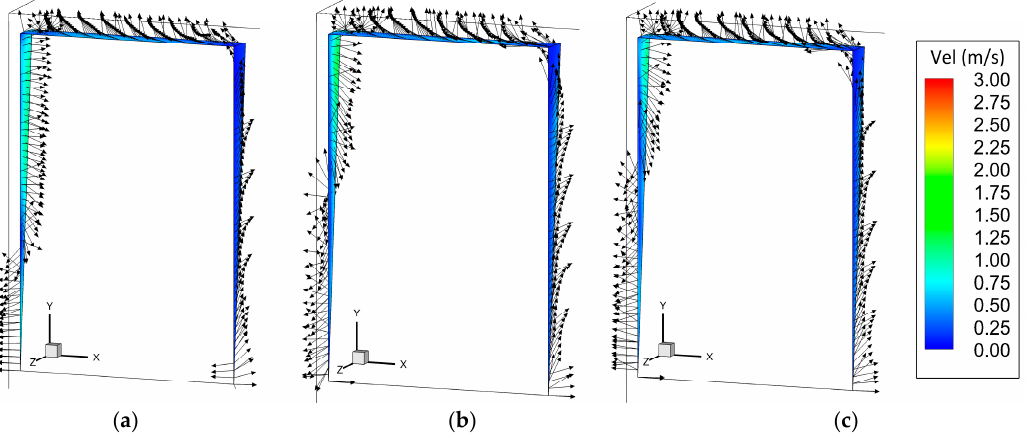
Figure 12. Vectors and velocity magnitude on the window opening for (a) 6 m/s, (b) 10 m/s, (c) 15 m/s wind speed, for 45 o wind direction.